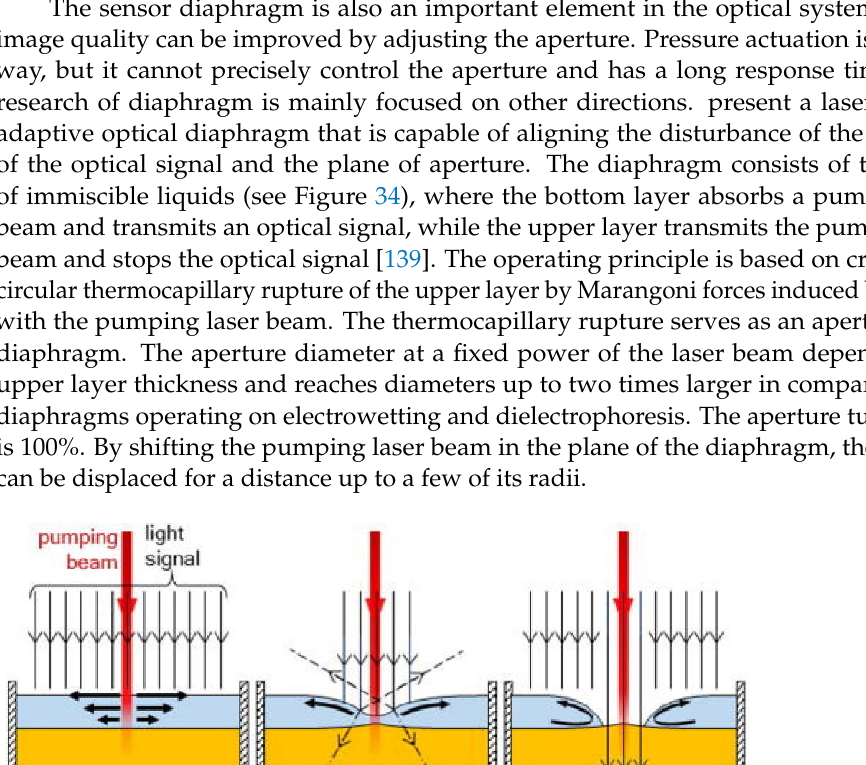
Figure 35. Phase modulator structure. ( a ) Cross-sectional view of the liquid phase modulator; the bottom electrode configuration: ( b ) key type; ( c ) interdigital type. Reprinted/adapted with permis- sion from Ref. [142]. 2021 American Chemical Society. Additionally, the interdigital type electrodes can better control the planar movement of liquid and be applied in many studies, as in [122,143]. The experimental results also show that the two electrodes can achieve 6.68 π and 9.366 π, respectively, at the same voltage of 150 V. This research has great application potential in adaptive optics of coher- ence tomography and phase shift interferometry.